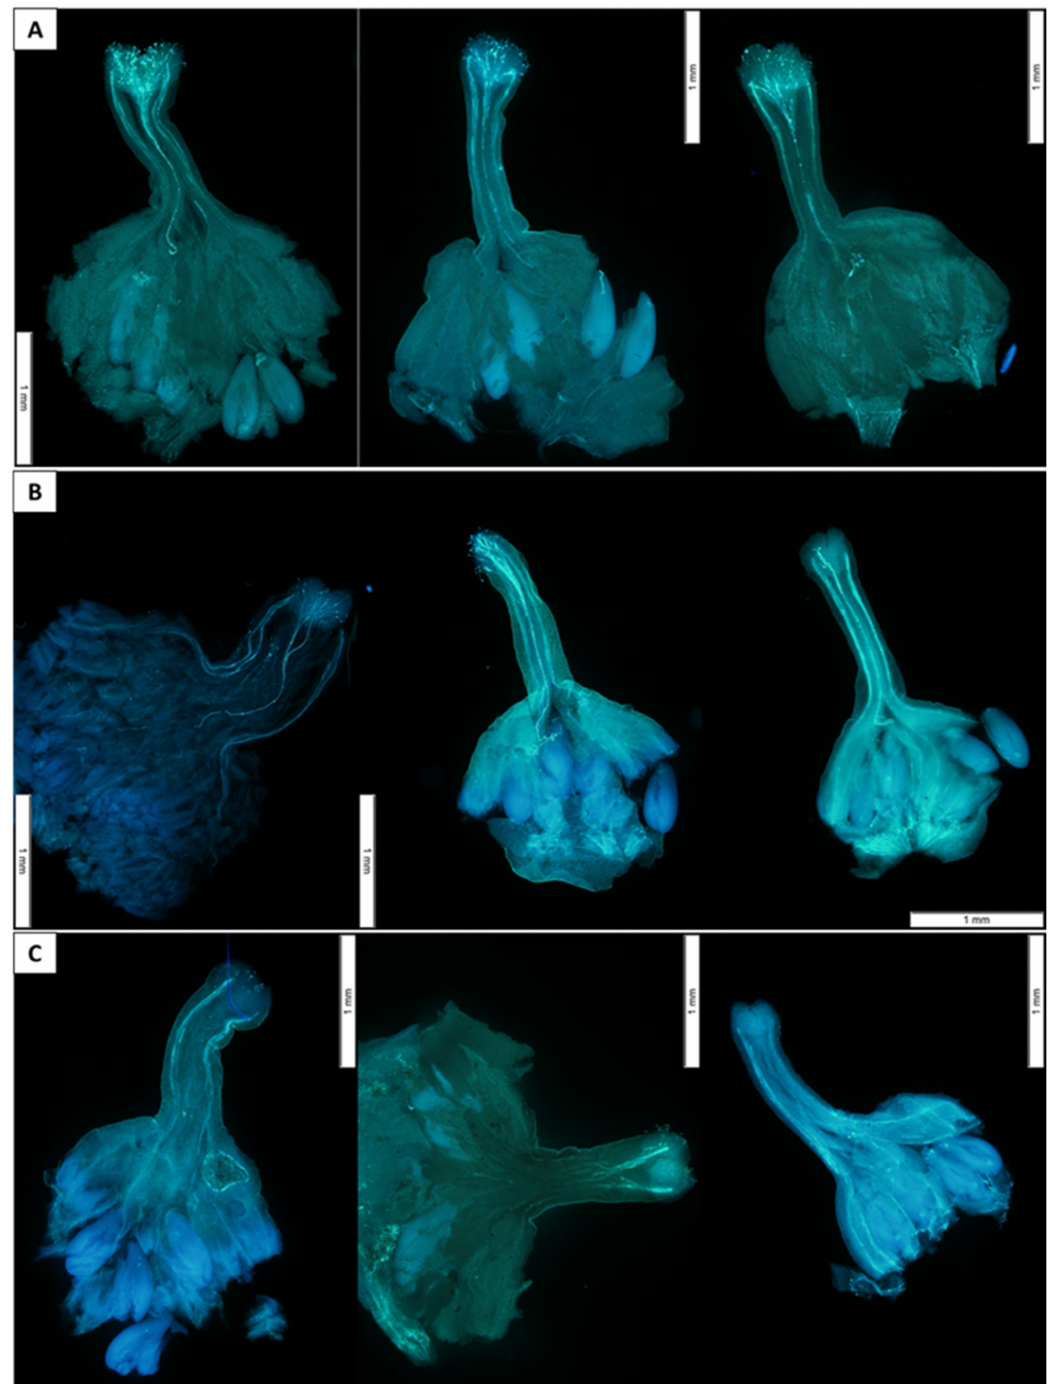
Figure 5. Stained pistils showing pollen tube growth from ( A ) intraspecific, ( B ) interspecific, and ( C ) self crosses of Osmanthus heterophyllus 24 h (left), 48 h (middle), and 72 h (right) post-pollination. Crosses shown from top to bottom are: O. heterophyllus ‘Rotundifolius’ × O. heterophyllus ‘Kaori Hime’, O. heterophyllus ‘Rotundifolius’ × O. armatus ‘Longwood’, and O. heterophyllus ‘Rotundifolius’. Pistils were fixed, rinsed, hydrolyzed, stained with decolorized aniline blue, and placed on microscope slides. Slides were observed after 1 hour using an Olympus BX-60 compound microscope with an Olympus Q Color 5 digital camera for image